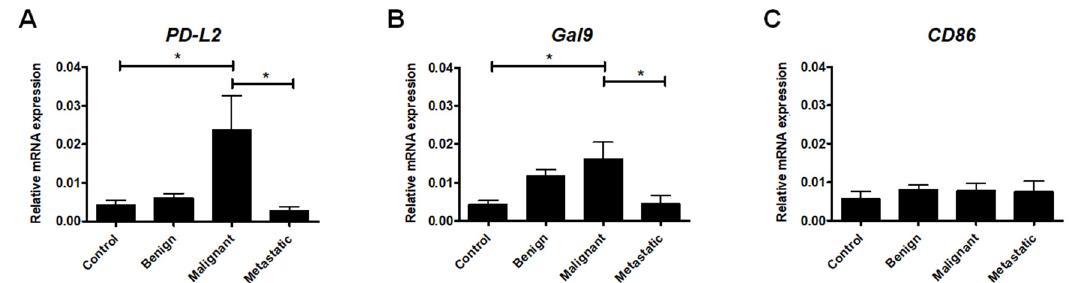
Figure 1. The expression of ligands regulating T cell activation at the mRNA level in canine mammary tumors. The relative PD-L2 ( A ), Gal9 ( B ), and CD86 ( C ) gene expression levels in healthy mammary gland tissue (Control) and in benign, malignant, and metastatic canine mammary tumors. The results are presented as the mean ± SEM. A one-way ANOVA and Tukey HSD post hoc test were applied. Significance levels are indicated as follows: * p < 0.05 .